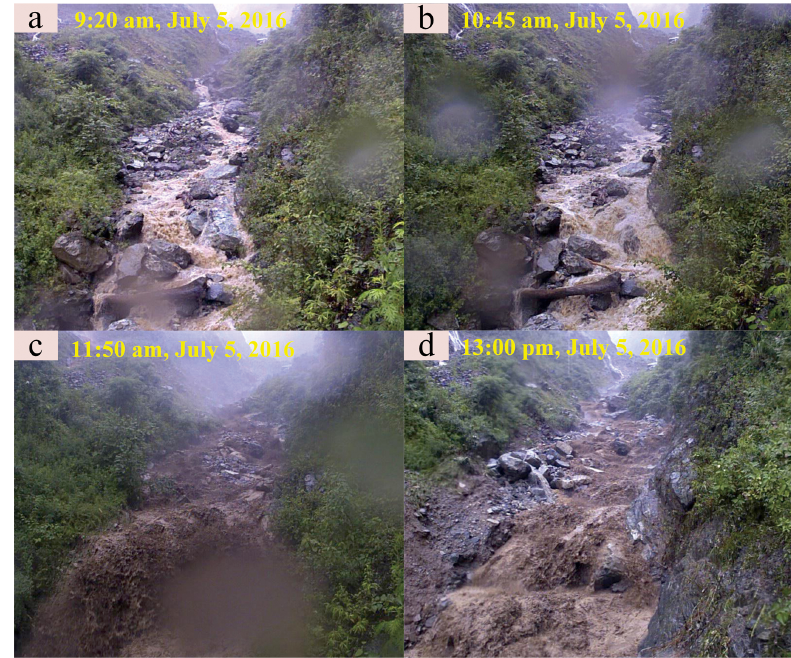
Figure 12. Debris flow event recorded in Er (CID W7, Wenchuan County; no. 1 in Fig. 1c) on 5 July 2016 (Cui et al., 2018).